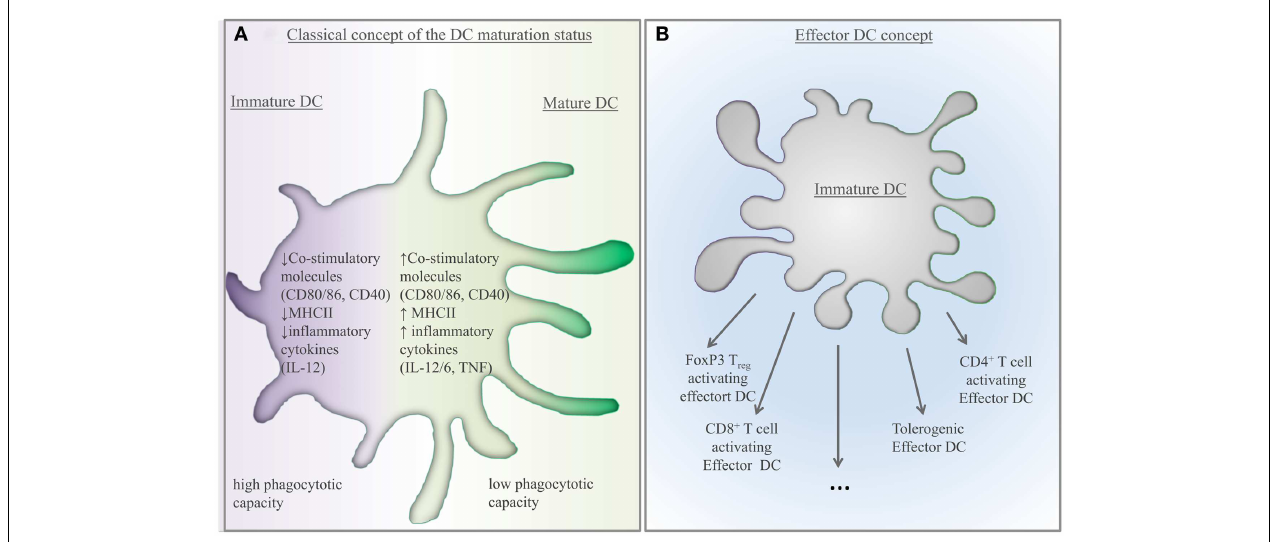
DCs were able to induce tolerance. (B) Based on novel observations, the existence of multiple effector DCs has been suggested by Reis and Sousa (55). According to this model, immature DCs develop into various types of effector cells. Consequently, effector DCs, capable of inducing tolerance, are the effector tolerogenic